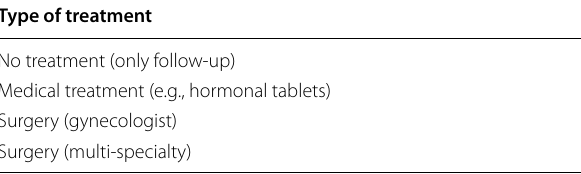
Table 4 Types of endometriosis treatment classification (sample) Type of treatment